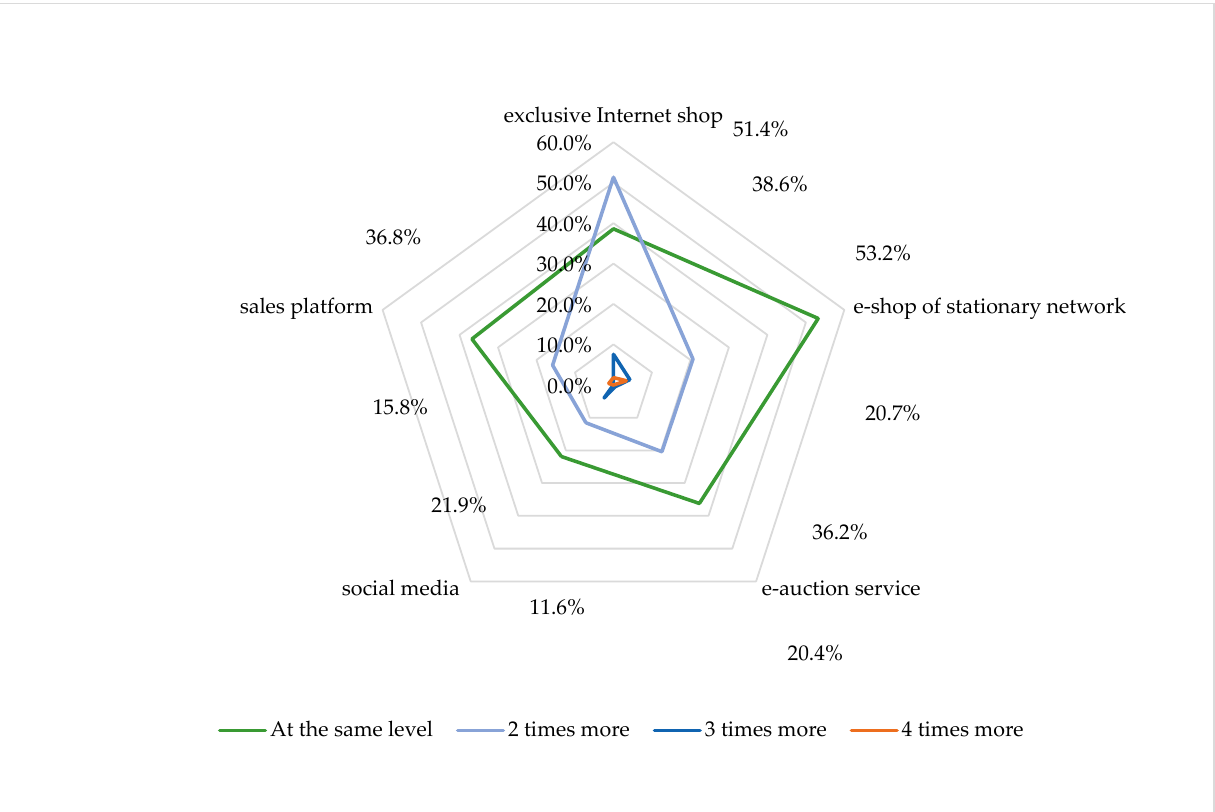
Figure 2. Declarations of the frequency of purchases in selected sales units operating on the Internet during the COVID-19 pandemic.